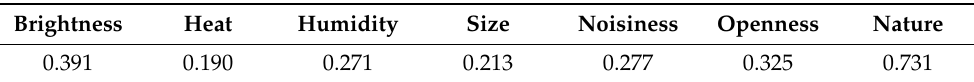
Table 3. Subjective evaluation of environmental factors of staying room. Significance difference test for LH-A and LH-B p